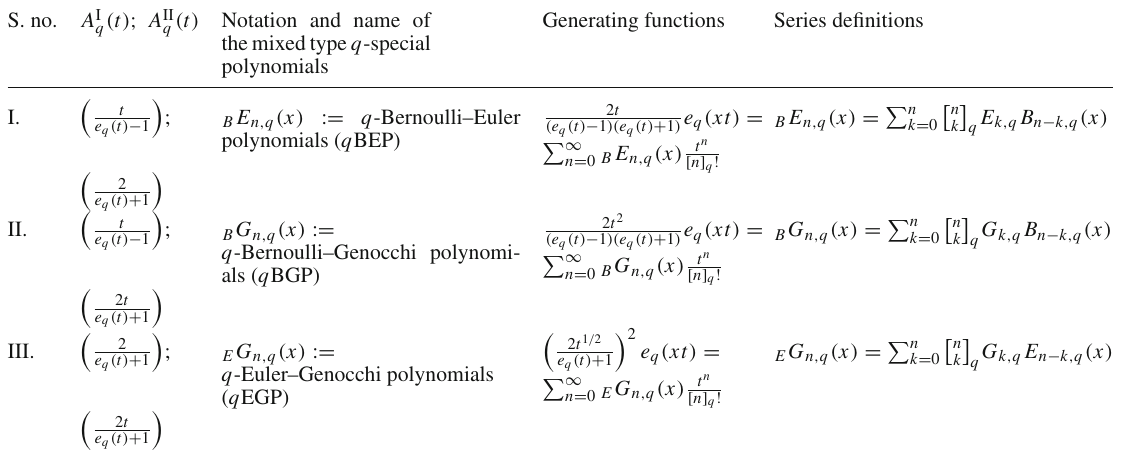
Generating functions Series